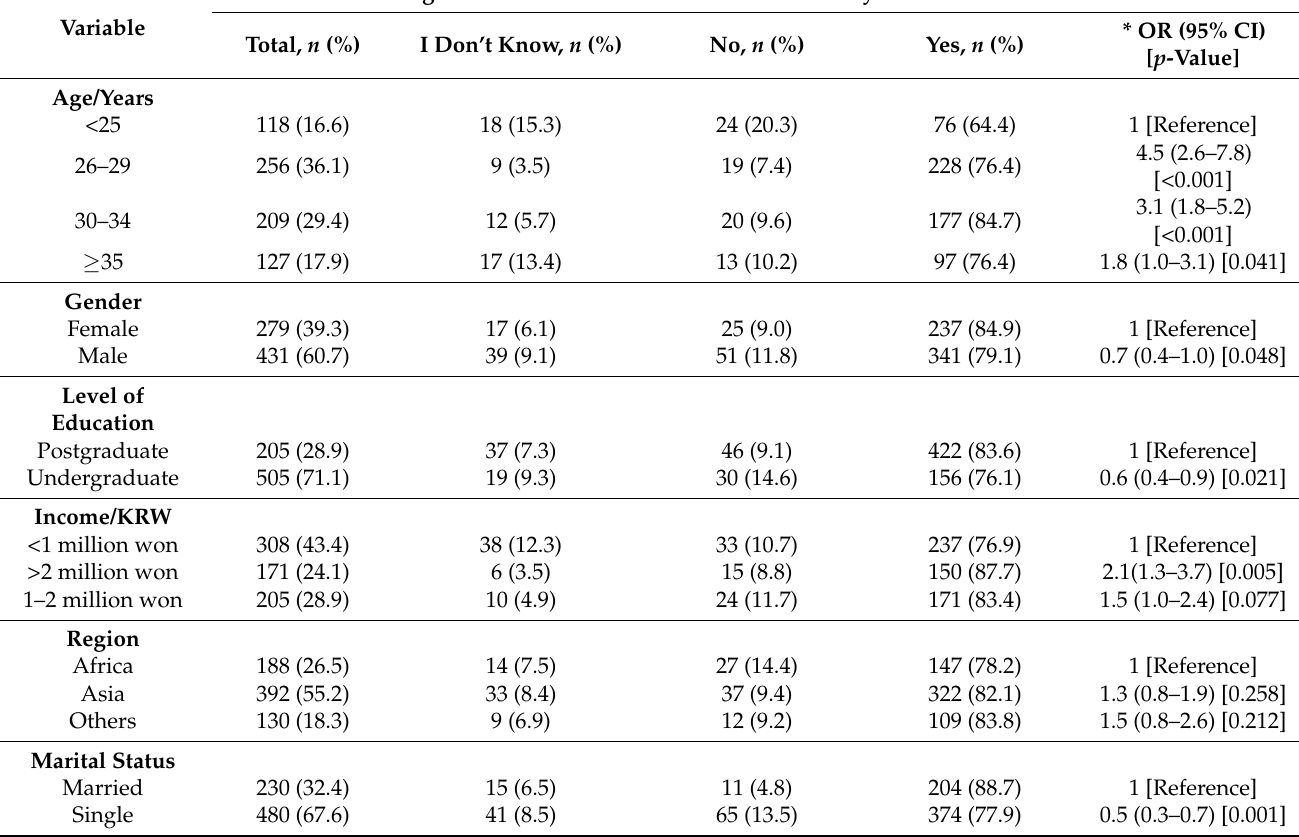
Table 1. Sociodemographic characteristics of study participants by their knowledge about COVID-19 vaccine and its availability in South Korea ( N =